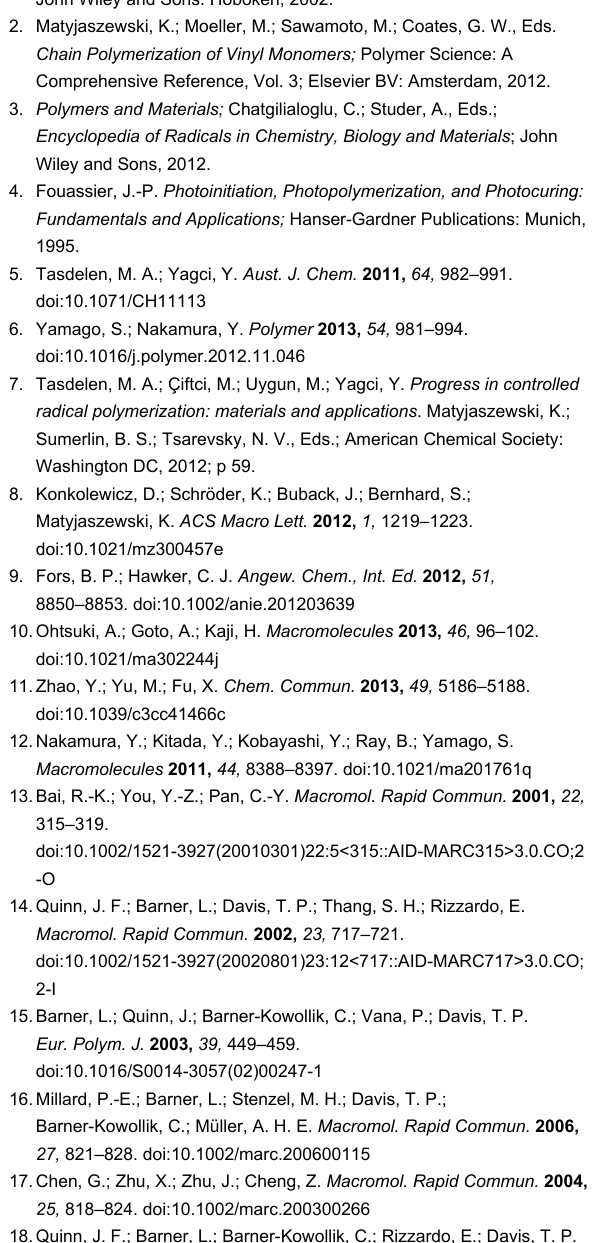
Figure 3: Experimental setup for the photopolymerization using the